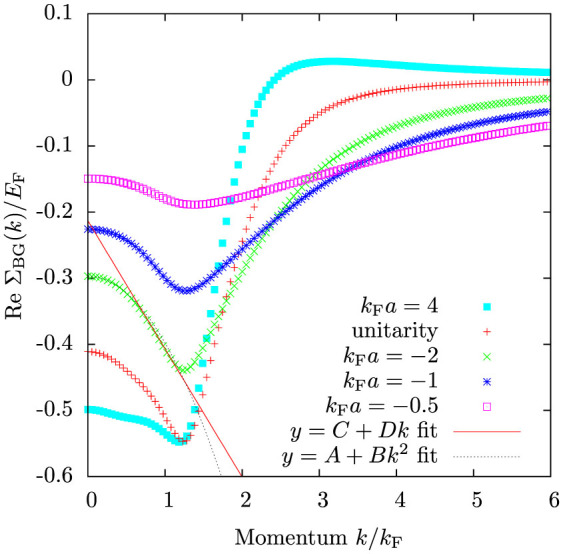
The real part of the Brueckner-Goldstone self-energy ΣBG as a function of momentum for various interaction strengths.Shown are also a y = A + Bk2 fit to the kFa = −2 self-energy data in the range  used for determining the zero momentum effective mass and a linear y = C + Dk fit for the data in the range  for obtaining the effective mass at the Fermi surface. Here and elsewhere, unless otherwise pointed out, the temperature is T = 0.2 TF and the convergence factor η = 0.05 EF.